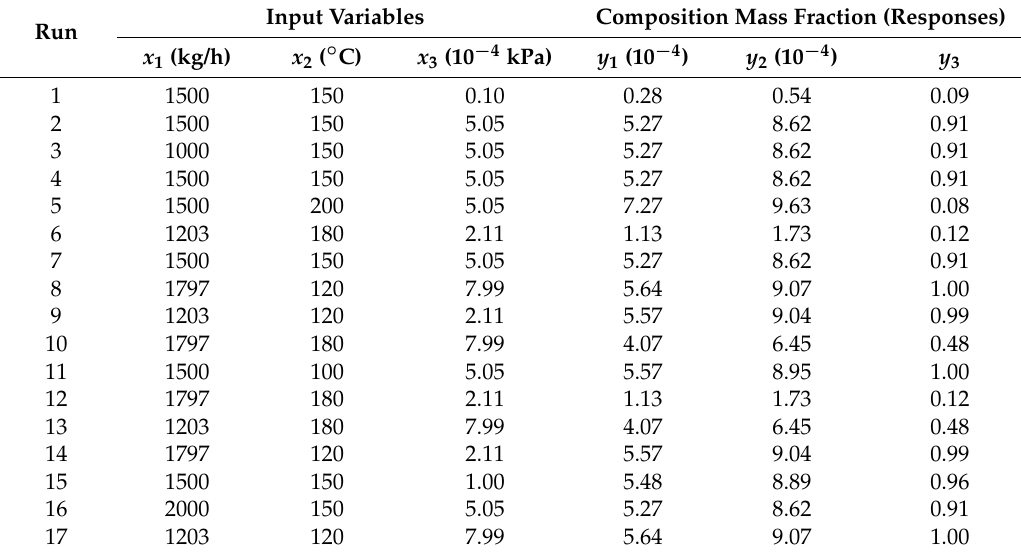
Table 8. Experimental design using Central Composite Design (CCD) of 17 runs.